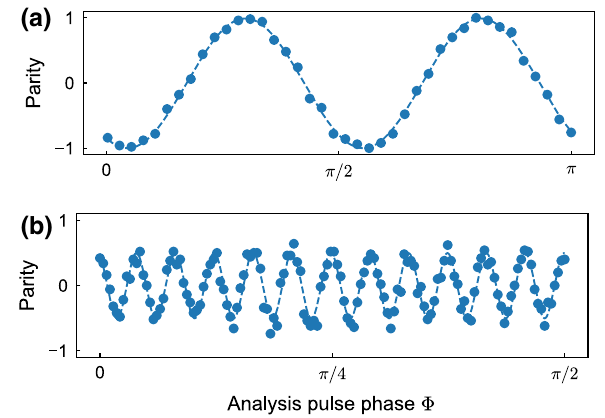
FIG. 16. (a) Parity oscillations after a Mølmer-Sørensen gate on two ions followed by an evaluation pulse with phase (cid:18) . The amplitude of the parity oscillations is C 2 = 0.995 ± 0.011 with 100 measurements per data point. Together with populations P 2 ( SS , DD ) = 0.9988 ± 0.0005 we determine a fidelity of F 2 = 0.997 ± 0.006. (b) Parity oscillations of a 24-ion GHZ state with 100 measurements per data point. The parity contrast drops to C 24 = 0.501 ± 0.013, the population to P 24 ( S · · · S , D · · · D ) = 0.588 ± 0.006. We obtain a fidelity of F 24 = 0.544 ± 0.007; more than 6 standard deviations above the 24-partite entangle- ment threshold of 0.5. Measurement uncertainties are smaller than the marker